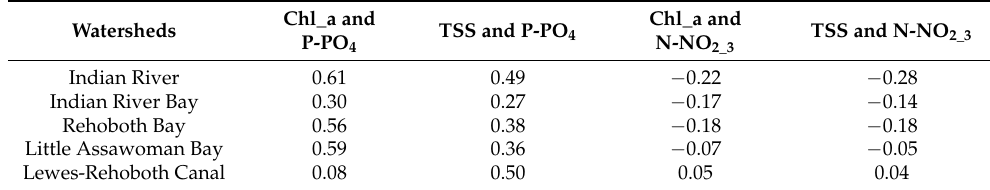
Table 3. Result of the ANOVA summarizing p values for null hypothesis and variance component analysis explained by watershed as the predictor variable. Abbreviation: Chl_a = chlorophyll a; Cl = chloride; Sal = salinity; TempWater = water temperature; DO = dissolved oxygen; N ‐ NO 2_3 = ni ‐ trite+nitrate; P ‐ PO 4 = dissolved phosphate as P; Secchi = Secchi depth; N ‐ NH 3 = dissolved ammonia as N; TSS = total suspended solids.